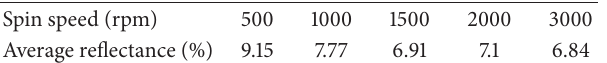
Table 1: Average reflectance (between 300 and 1100nm) of texture surfacesiliconsubstratewithZrO 2 -polymerARC(adaptedfromour previous work